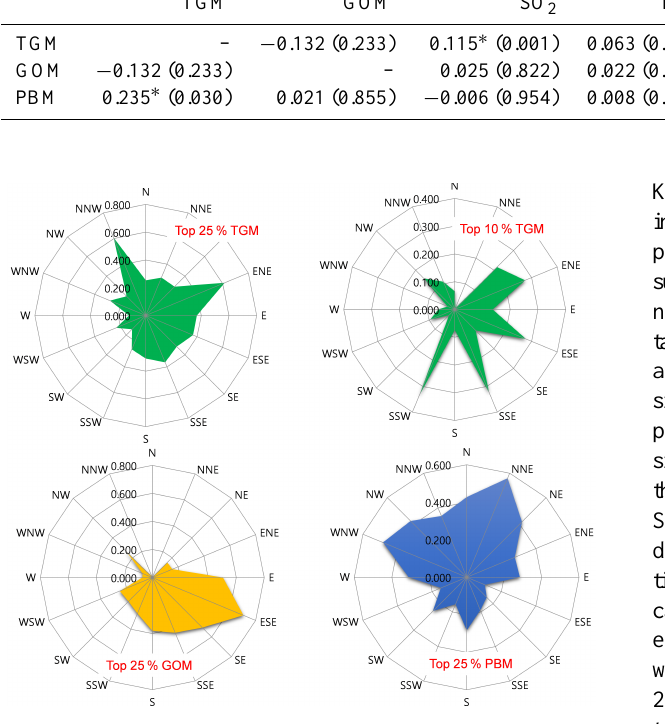
Figure 5. CPF plots for TGM using the top 25% (left upper panel) and the top 10% (right upper panel) as a criterion, and for GOM (left bottom panel) and for PBM (right bottom panel). For both GOM and PBM, the criterion of the top 25% concentration was